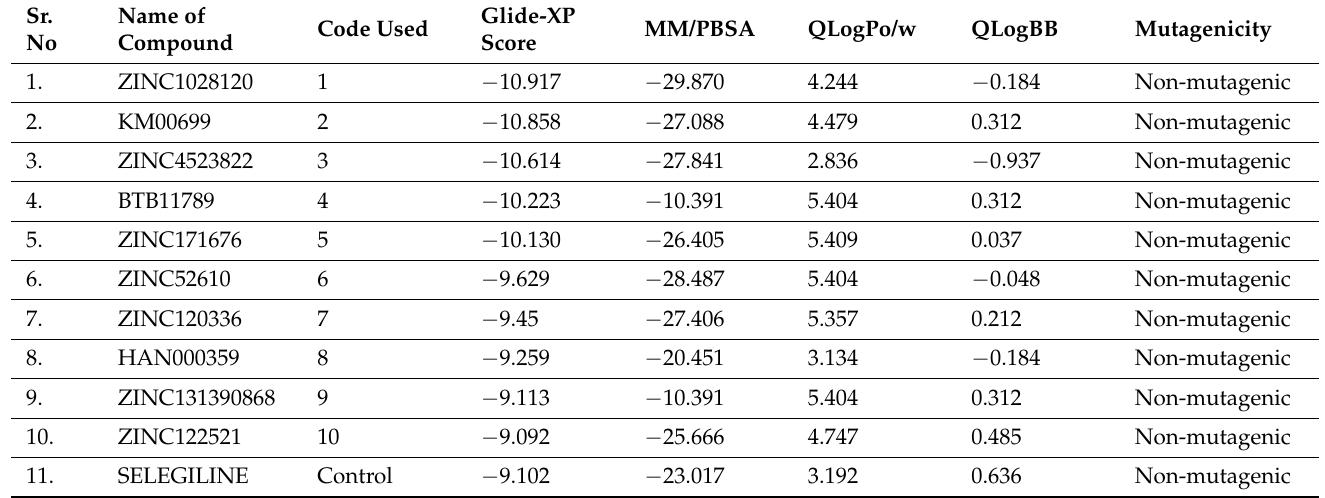
Table 3. Summary of docking scores from various docking packages obtained for ligands identified for enzyme-based screening. QikProp score for various ligands and TOPKAT mutagenicity prediction for ligands identified for enzyme-based